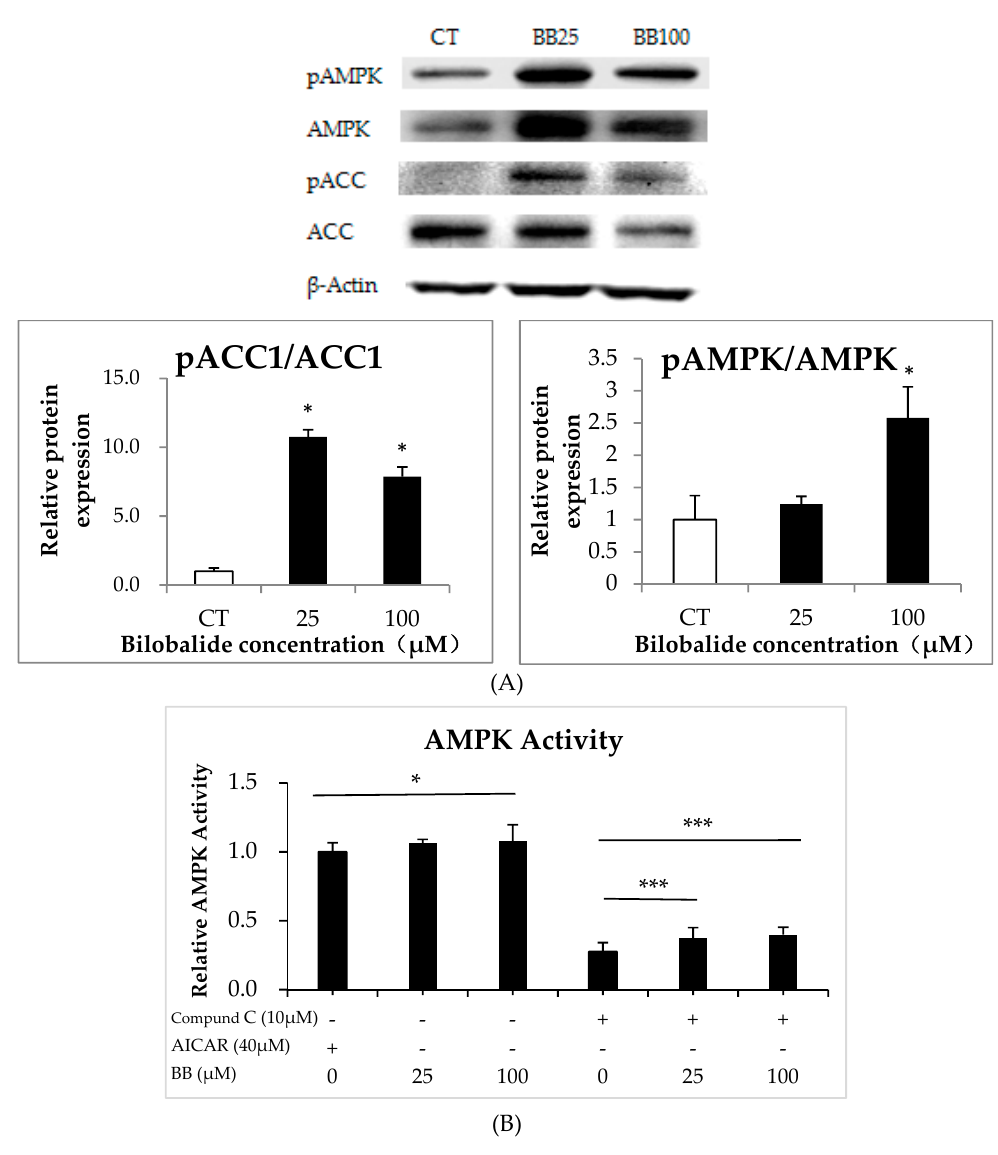
Figure 7. Bilobalide promotes AMPK phosphorylation and signaling. (A) Total protein was extracted from differentiated adipocytes, and changes in ACC1 and AMPK phosphorylation were determined. (B) Relative AMPK activity from ELISA assay following treatment with AICAR (40 μ M), compound C (10 μ M), and 25 μ M and 100 μ M bilobalide presented as a percentage relative to the control group. * p < 0.05, *** p < 0.001.